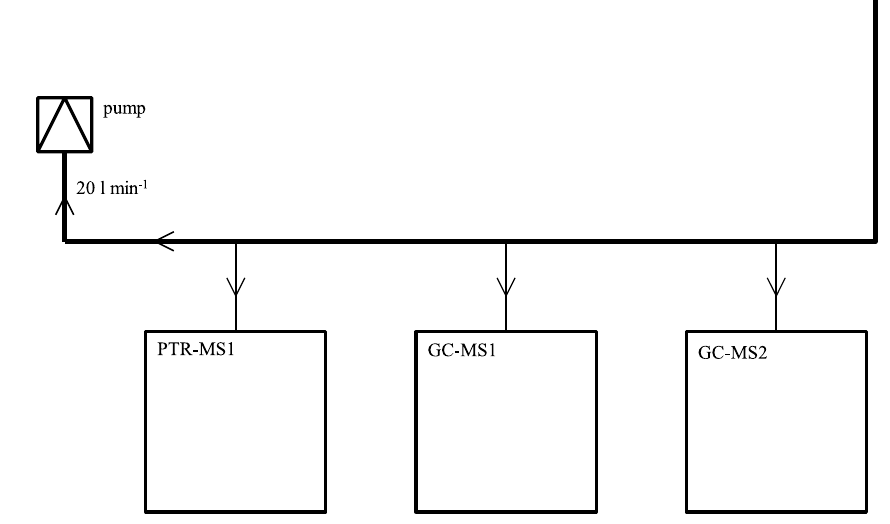
Figure 1. PTR-MS1, GC-MS1 and GC-MS2 shared the same inlet, which was sampling ca. 10m above the ground.